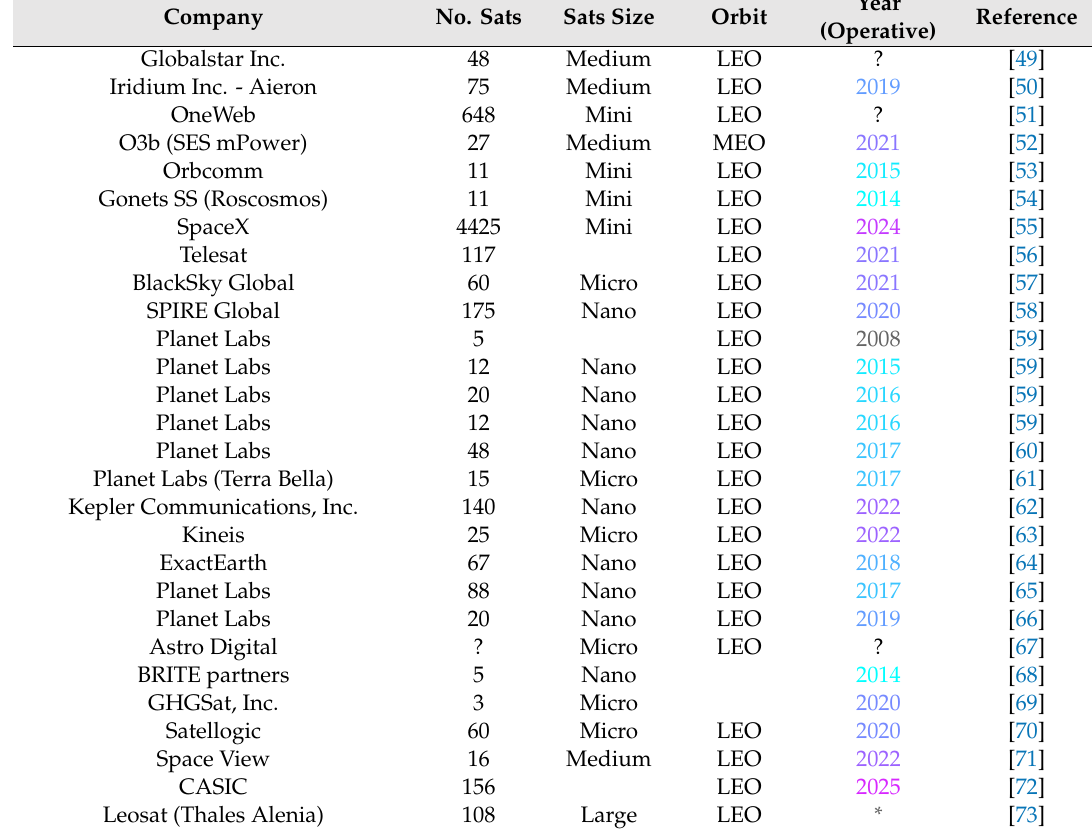
Table A1. List of constellations surveyed in this work. “?” stands for unknown; “*” stands for “dormant or cancelled